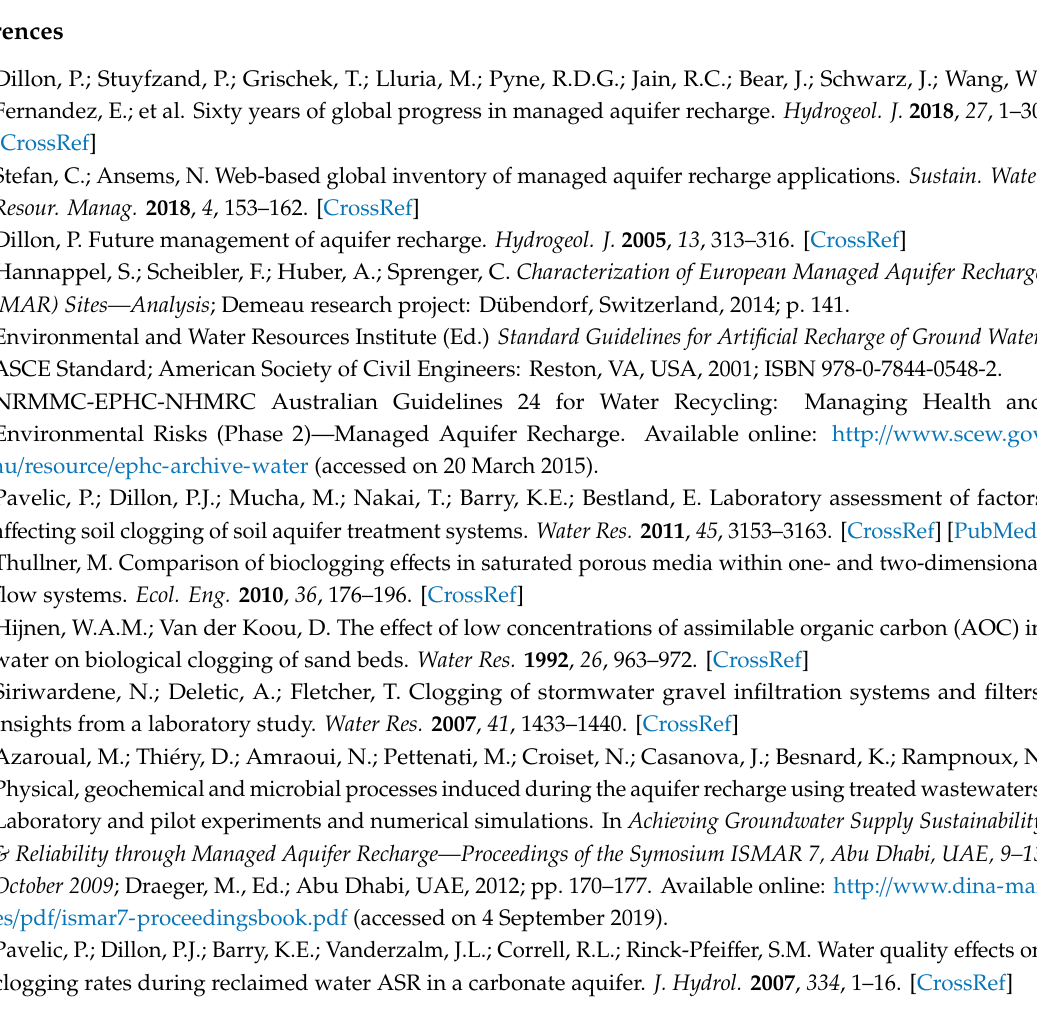
Figure S1: Calculation of mean and minimum tension values during the wet phase and maximum tension values during the dry phase for every cycle of scenario 1, Figure S2: Tension measurements of the upper layer during scenario 1 for (a) FIU / tank and (b) FIU / column experiments and adapted laboratory tension values by regression function with 95% confidence interval